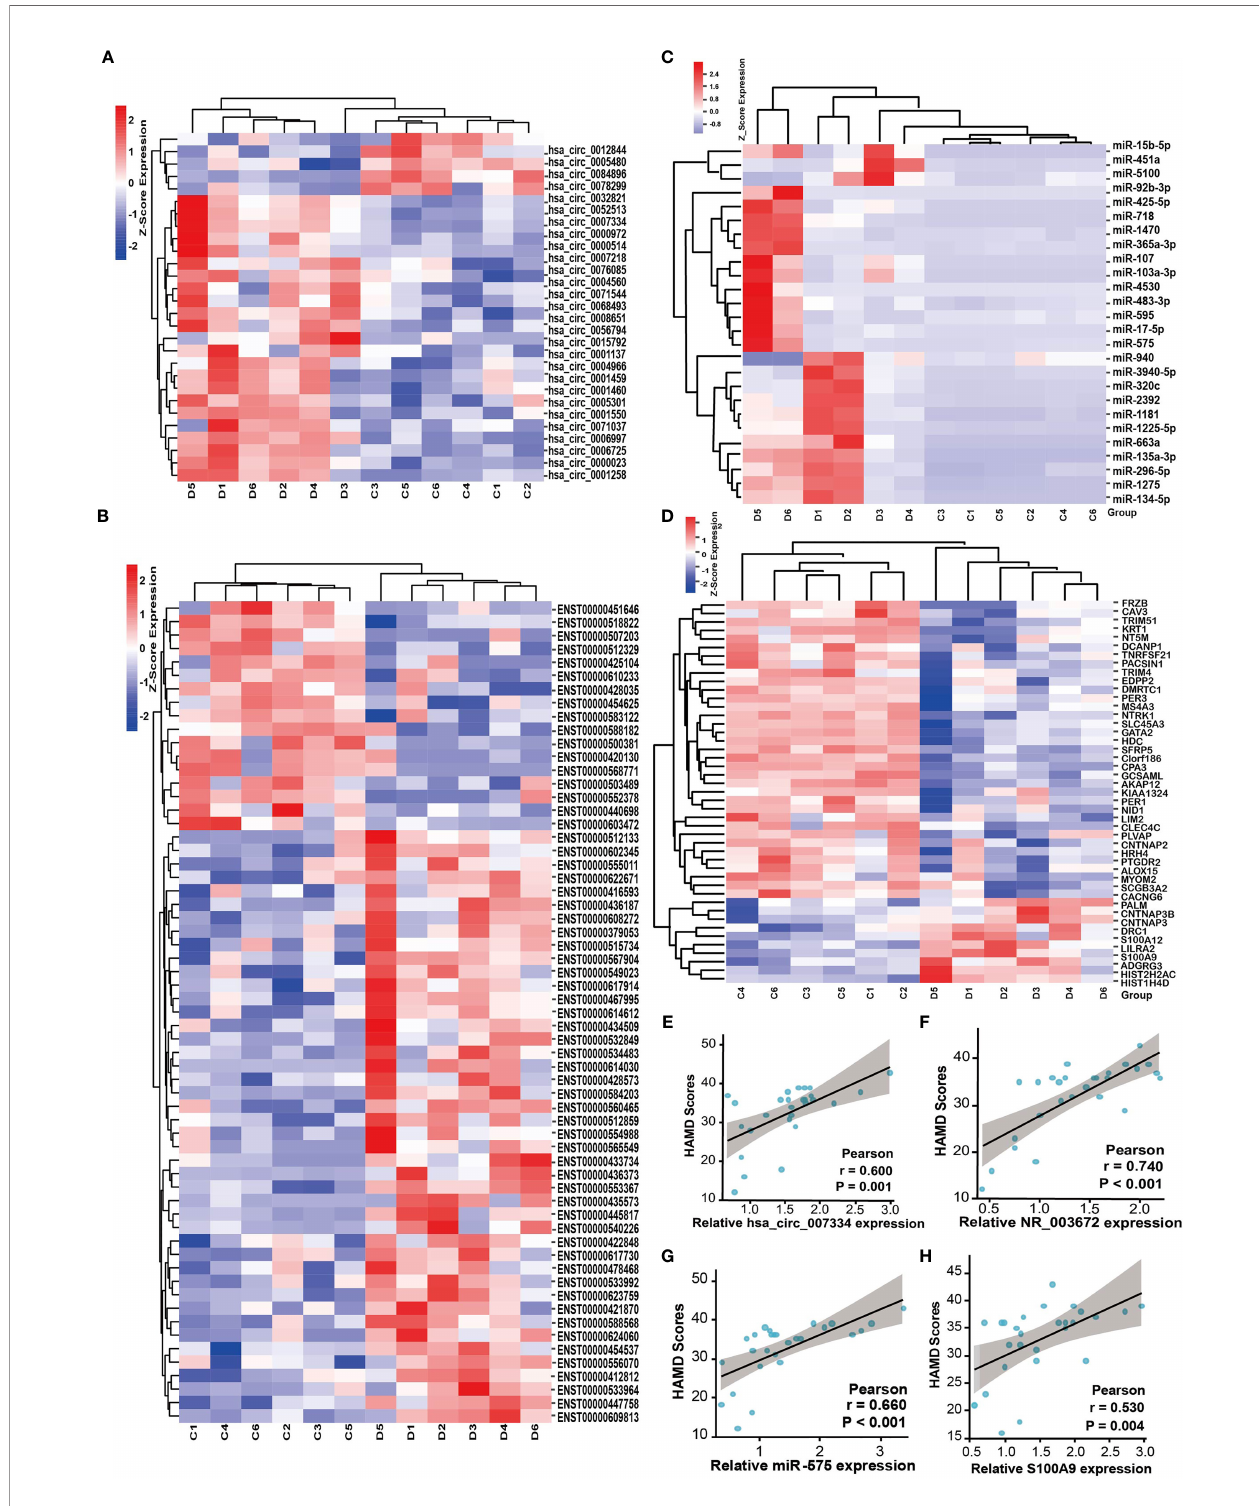
FIGURE 6 | Depression is positively correlated with cancer-associated genes. Heat map of tumor-associated circRNAs (A) , lncRNAs (B) , miRNAs (C) , and mRNAs (D) identi fi ed from the DEGs, respectively. D, depression patients; C, healthy controls. Red indicates high relative expression and blue indicates low relative expression. FC >2 or FC <0.5, p < 0.05. (E – H) The correlation between HAMD scores of depression patients and the relative expression of tumor-associated genes circ-0007334 (E) , NR_003672 (F) , miR-575 (G) , and S100A9 (H) ,